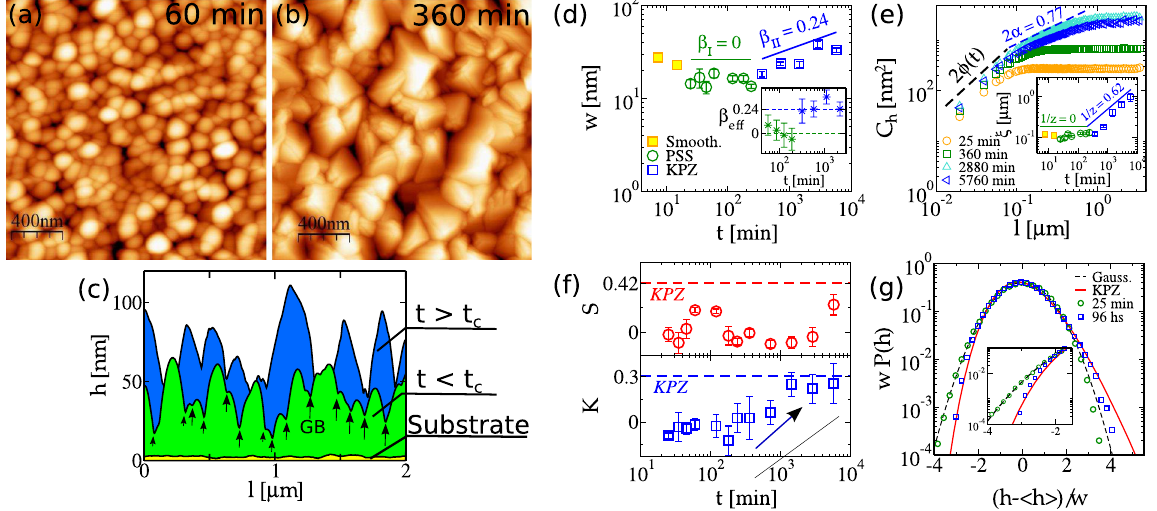
Figure 1. AFM images of CdTe surfaces for films grown at ( a ) 60 min (PSS regime) and ( b ) 360 min (beginning of the KPZ scaling). Typical 1D profiles are sketched out in ( c ). Black arrows indicate grain boundary (GB) sites considered in MC simulations. ( d ) Global CdTe surface width ( w ) as function of t . Different colored symbols and solid lines indicate different regimes. Inset shows the effective β exponent in time. ( e ) Height difference correlation function ( C h ) versus l for different deposition times. Dashed lines are guides to eyes with slopes 1.2 and 0.77 (KPZ) 13 . Inset shows the temporal variation of the correlation length ξ . ( f ) Temporal evolutions of HDs’ skewness ( S ) and kurtosis ( K ). The dashed lines indicate the universal KPZ values. ( g ) Rescaled HDs (with null mean and unity variance) for CdTe films (symbols), compared with Gaussian (dashed) and KPZ (solid line) HDs. Inset shows the same data highlighting the left tails.